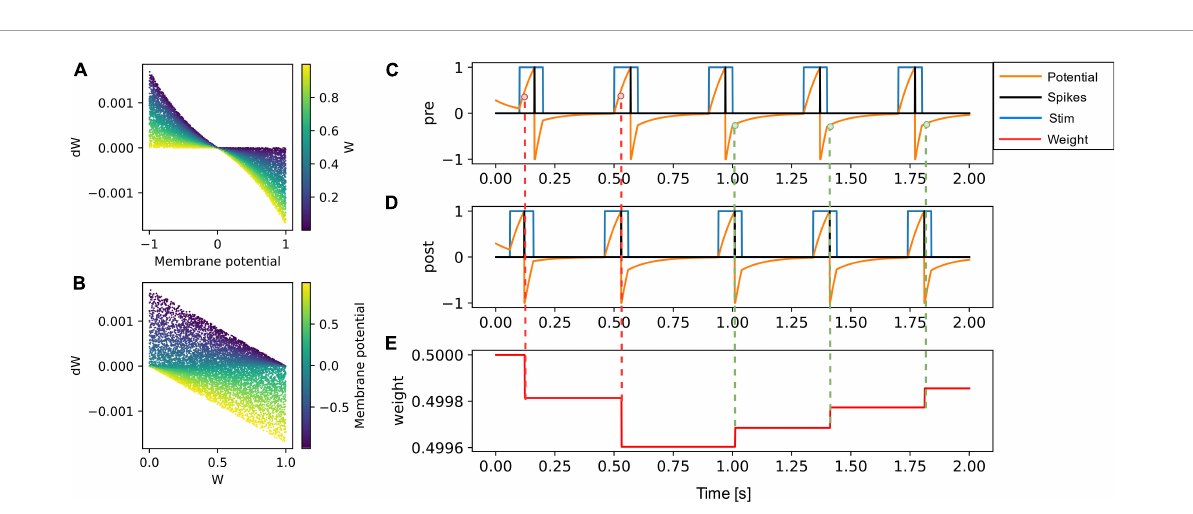
FIGURE2 (A) The weight update (dW) is plotted as a function of the membrane potential of pre-synaptic neuron, with the color code representing the initial weight. (B) The dW is linearly dependent on (1-W) for potentiation and on (W) for depression. The learning rate is set to 0.001 in both (A,B) . (C–E) A pair of pre-synaptic neuron and post-synaptic neuron is simulated along with their synaptic weight evolution. The weight update occurs at every post-synaptic neuron spike event and is negative if the pre-synaptic neuron membrane potential is greater than zero (shown in red dotted lines). The weight update is positive (green dotted lines) if the pre-synaptic neuron voltage is lesser than zero.